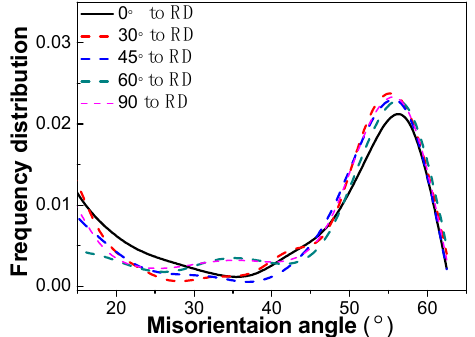
Figure 10. Angle boundaries distribution map of the pipeline steel in different directions.